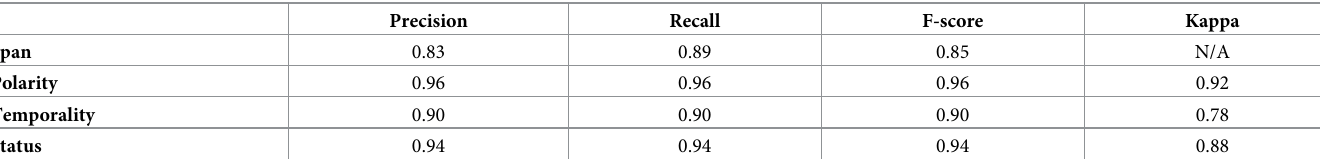
Table 2. Micro-averaged pairwise inter-annotator agreement.